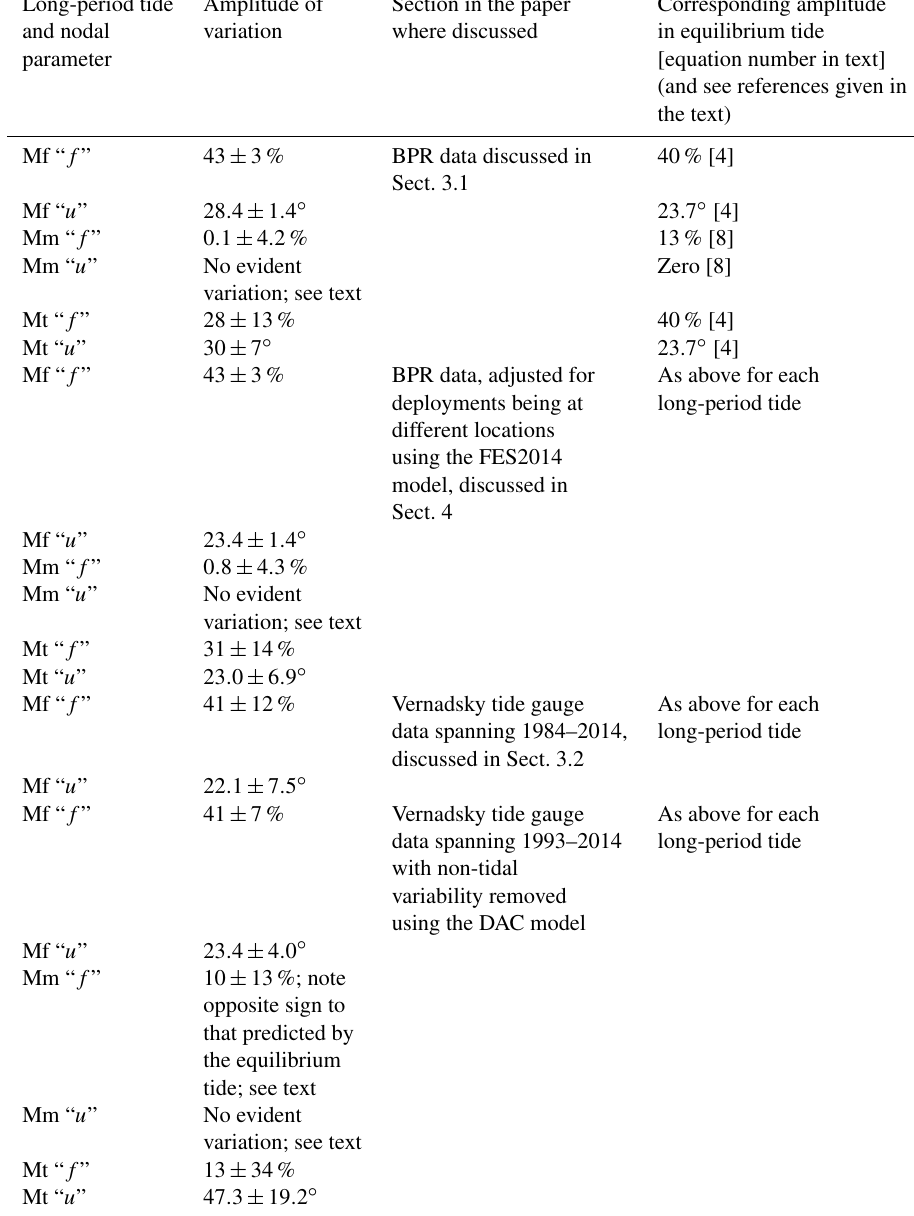
Table 1. A summary of estimates of nodal variation parameters for each long-period tide from Drake Passage BPR and Vernadsky tide gauge data. The last column shows the corresponding value in the equilibrium tide and appropriate equation number in the